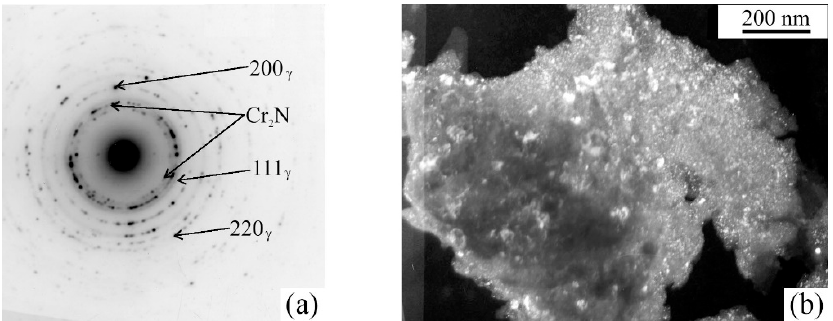
Figure 7. TEM structure of the MA powder mixture Fe–8.6Cr + 15Mn 2 N after annealing at 800 °C for 1 h: ( a ) SAED pattern; ( b ) dark-field image taken in the combined reflection (CrN, Cr 2 N).